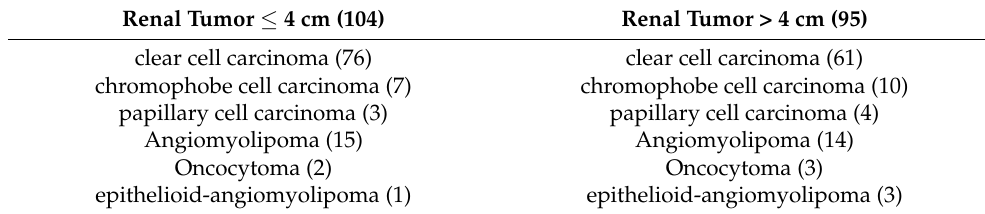
Table 1. Pathological type of registered patients.